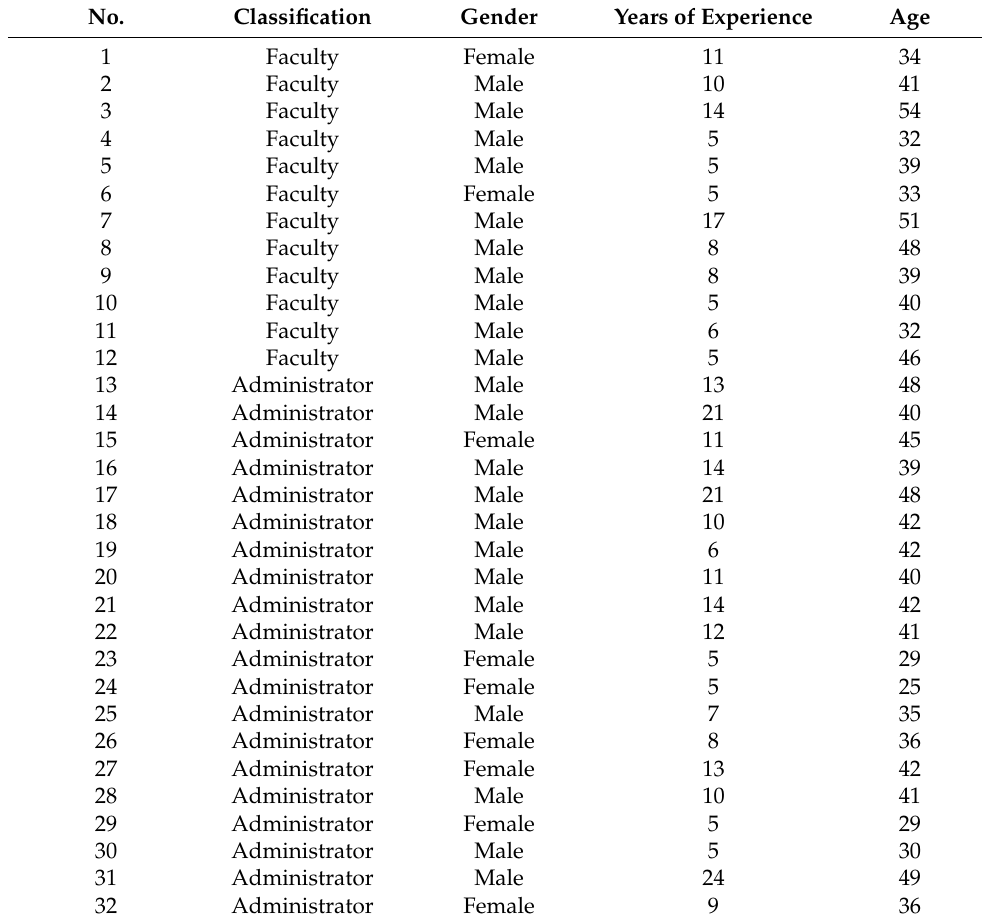
Table 1. Demographic characteristics of